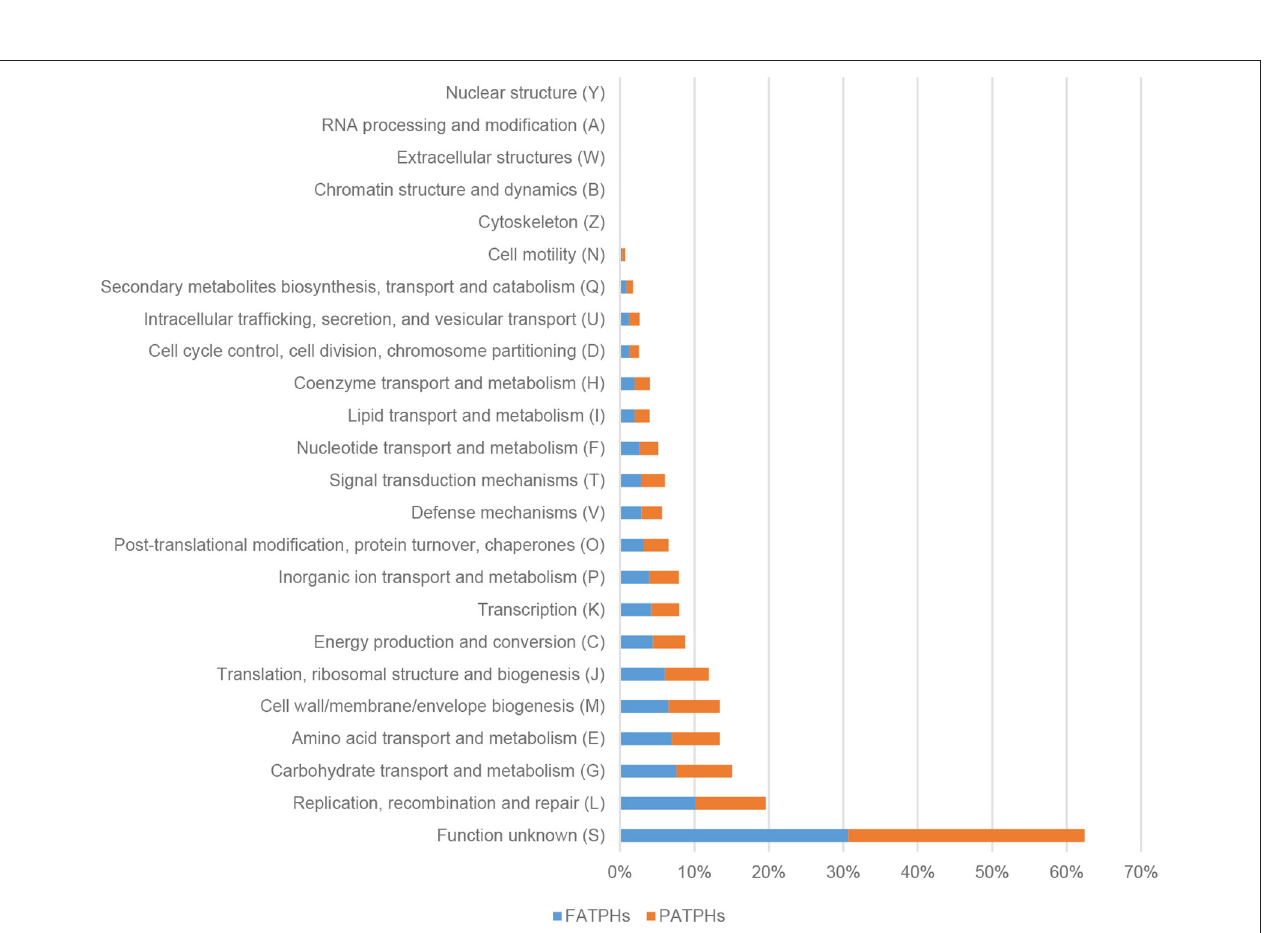
FIGURE 8 | Top 10 pathogens ranked by their gene abundances in PATPHs shown together with gene abundances of the corresponding pathogens in FATPHs.